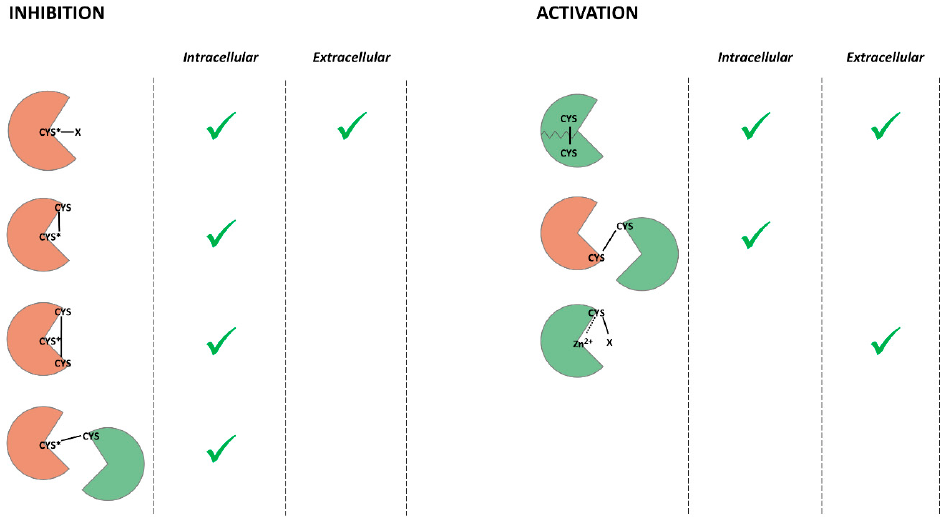
Figure 2. Mechanisms of the redox-mediated modifications of proteolytic enzymes resulting in the inhibition or activation of proteases. Inactive enzymes are indicated in red, and active enzymes are in green. Intracellular or extracellular localizations are indicated by green checkmarks.X—either SNO, SOH, SO 2 H, SSG (reversible PTM), or SO 3 H (irreversible PTM); CYS—cysteine; CYS *—catalytic cysteine; Zn 2+ —catalytic zink ion; solid line—the covalent bond; dashed line—the broken covalent bond.